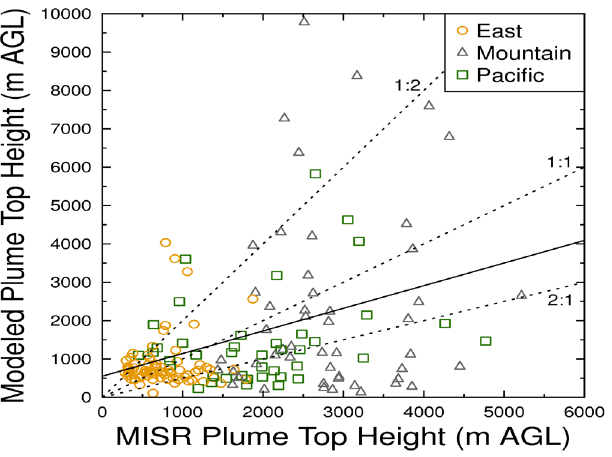
Figure 5. Regression analysis results for modeled plume heights ( y -axis) versus the MISR observed plume heights ( x -axis). Data points are color coded by region as shown on Figure 6. Also shown on the plot are the linear regression (solid line) and 1:2, 1:1, and 2:1 lines (dotted black lines). Note that a single value is off scale and not shown (MISR height = 2312 m; Modeled height = 18,699